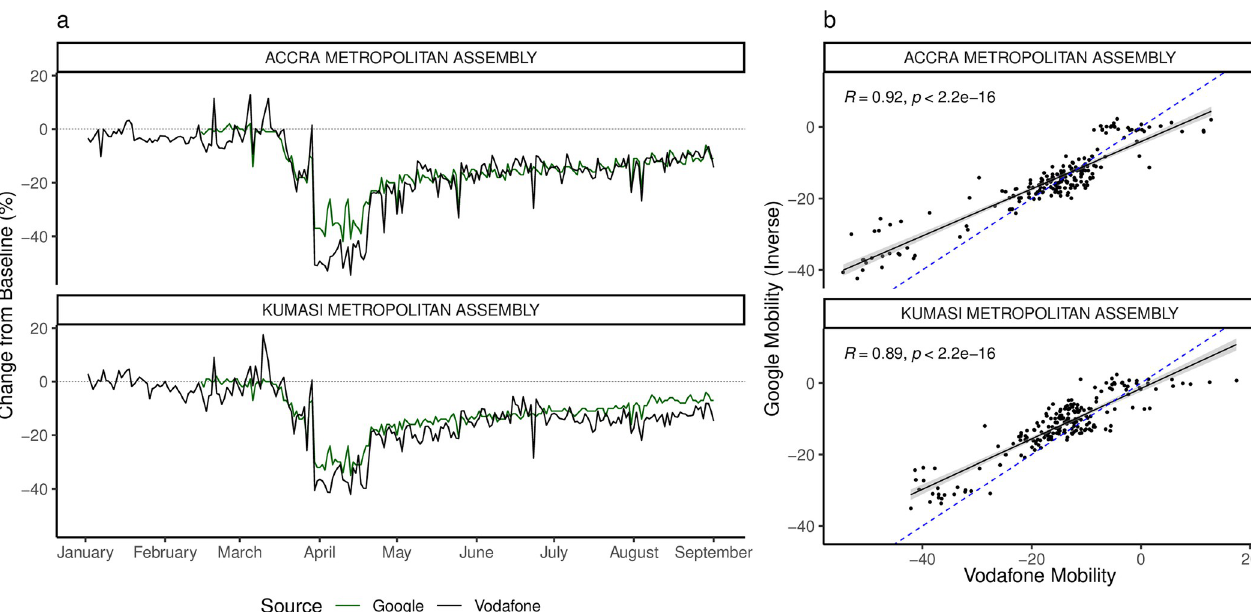
Fig 2. Mobility indicators in Accra and Kumasi metropolitan areas. a) A comparison of the Vodafone and Google mobility indicators in Accra and Kumasi Metropolitan Areas. b) The correlation between Vodafone and (inverse) Google mobility indicators. Blue dashed line indicates the best fit line. This shows a strong correlation between both mobility indicators across the study period. Note that these data are collected from two different sources (Google: GPS, Vodafone: CDRs) and describe different aspects of mobility (Google: activity in “residential” areas, Vodafone: travel between administrative